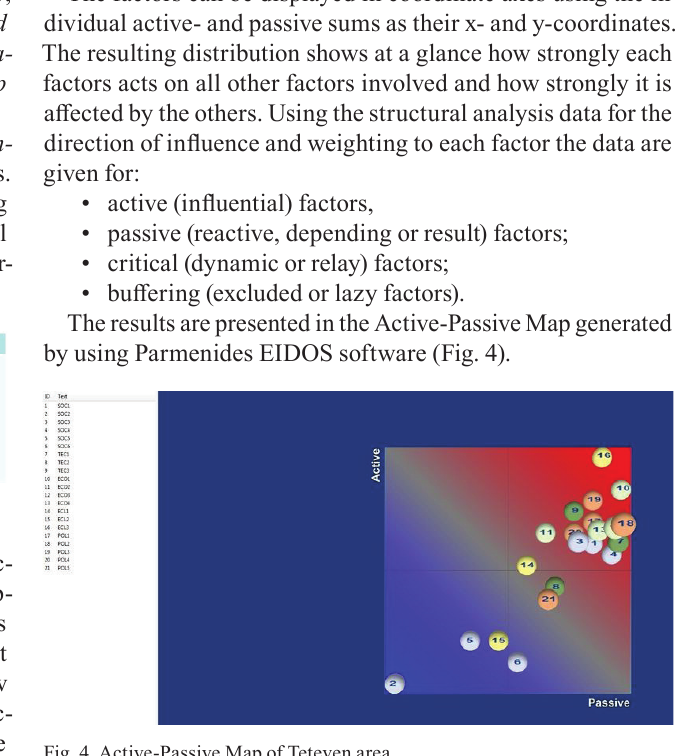
Fig. 4. Active-Passive Map of Teteven